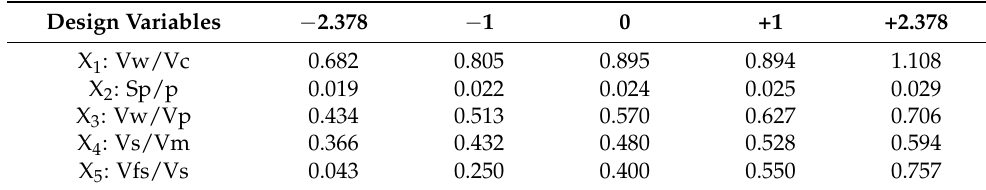
Table 1. Correspondence between the coded values and actual values of the design variables. Design Variables